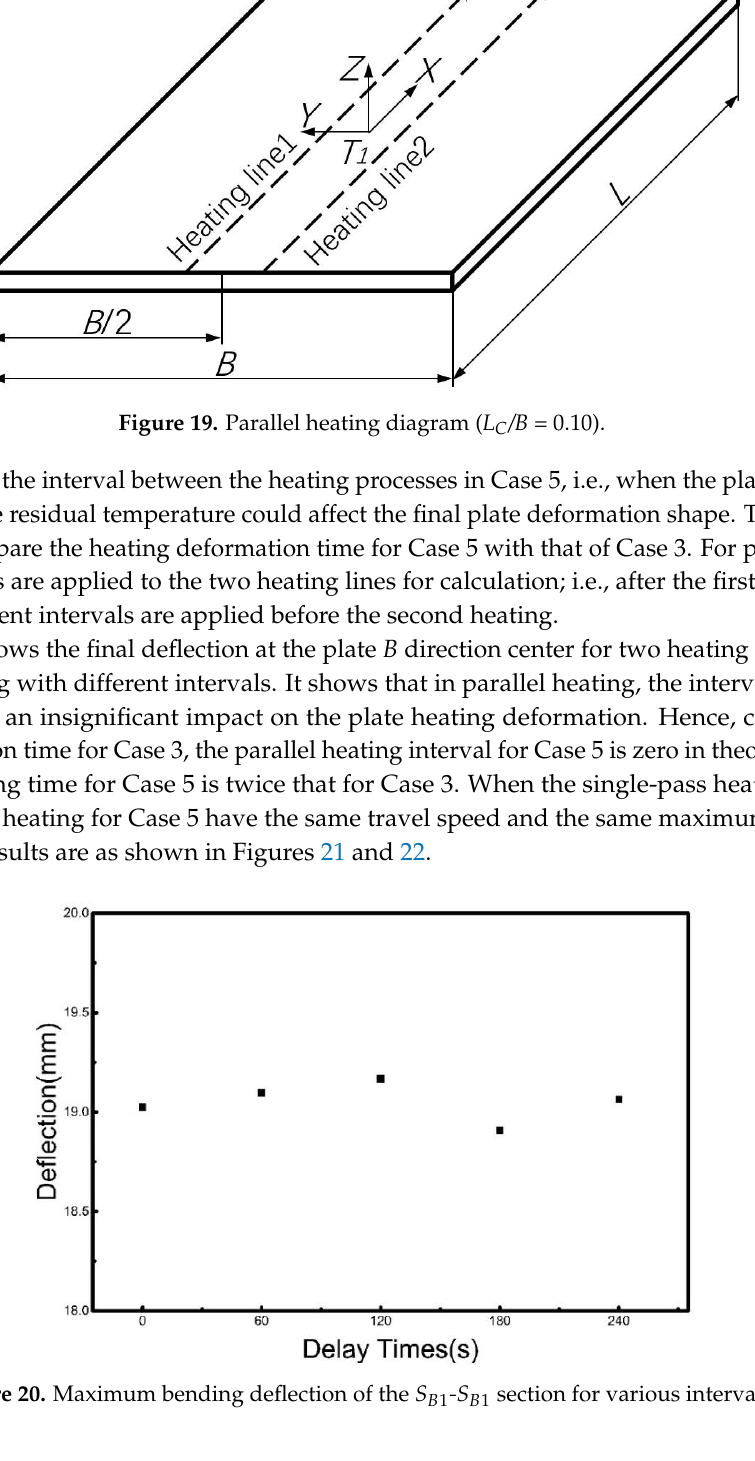
Figure 20. Maximum bending deflection of the S B 1 -S B 1 section for various intervals.